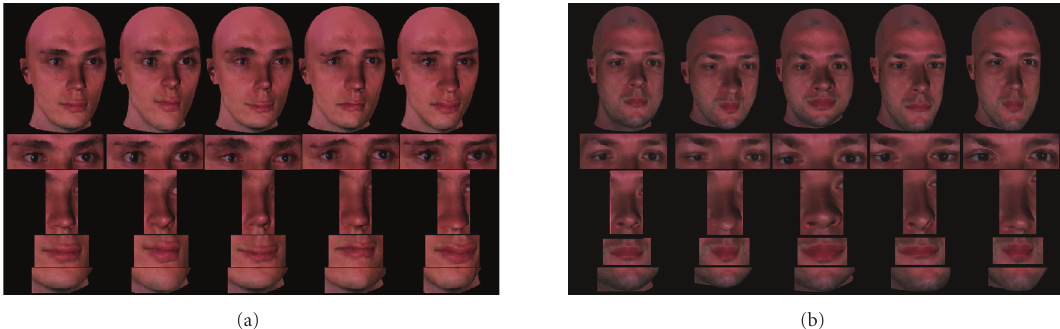
Figure 11: Feature-based face editing on the models of two individuals. In each example, the original model is shown in the top-left.